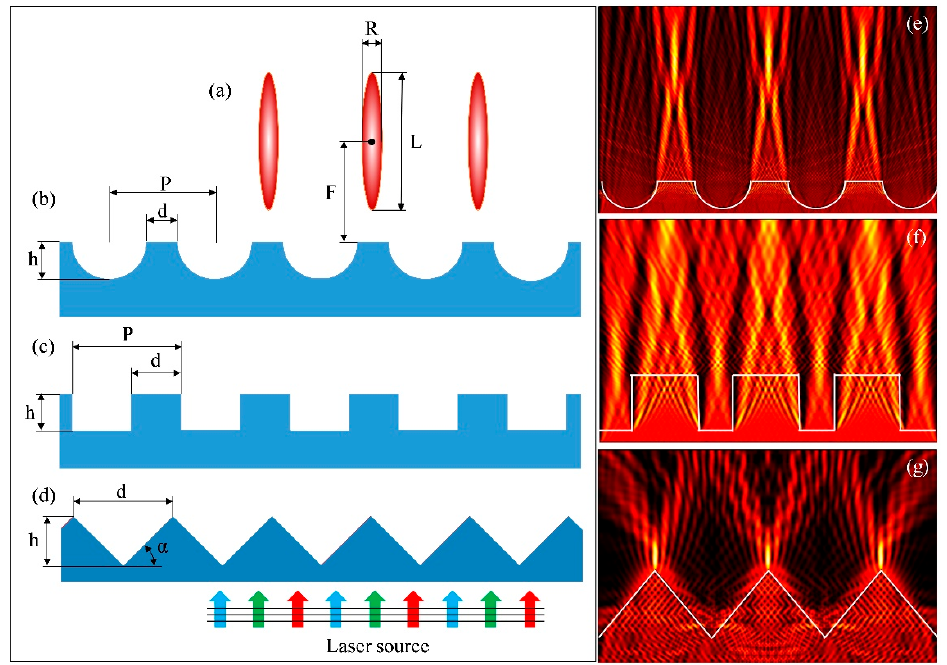
Figure 7. ( a ) Schematic diagram of a phase diffraction grating for a photonic jet. Schematic profiles of three types of phase diffraction gratings: ( b ) hemispherical, ( c ) rectangle, and ( d ) saw-tooth.